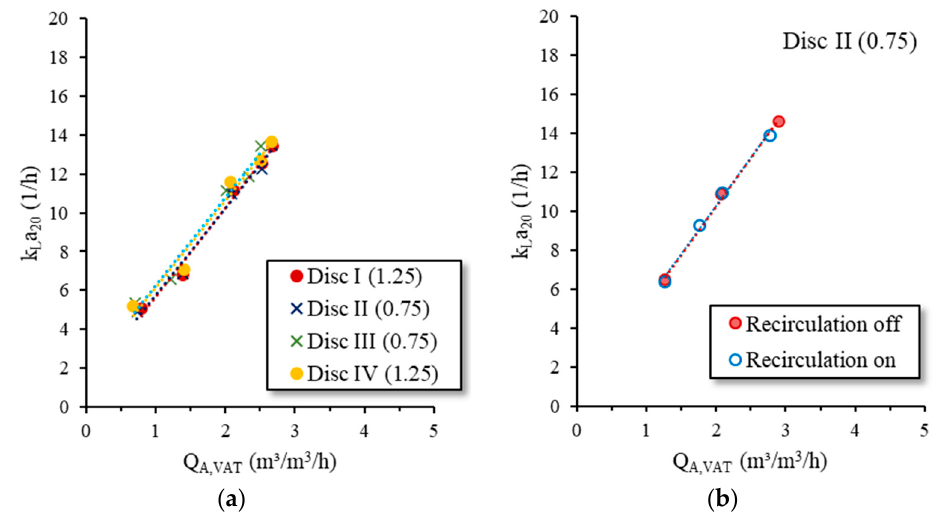
Figure 6. ( a ) Results of oxygen transfer tests in TW ( a ); ( b ) results of oxygen transfer tests in TW with Disc II (0.75) with and without recirculation.